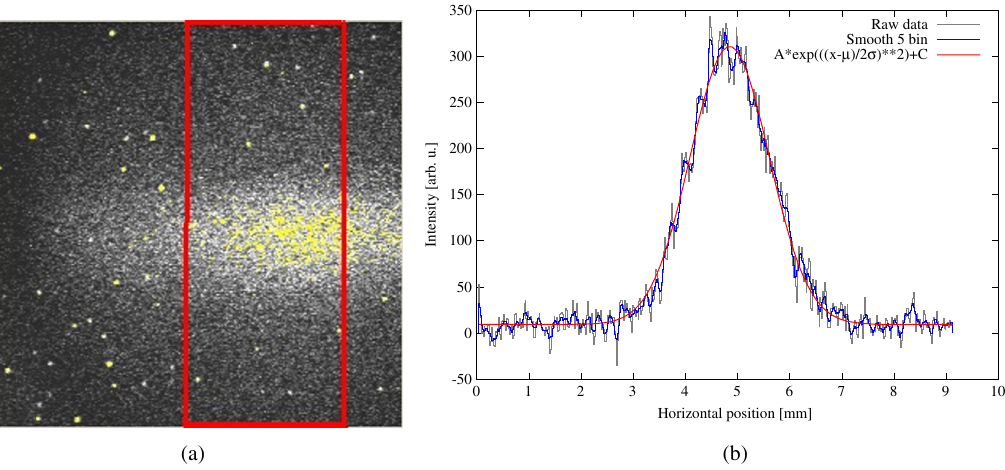
FIG. 9. Typical results of horizontal beam-size measurements with the CCD camera. (a) Fluorescence image of a 24 Mg þ beam after injection. In this picture, the abscissa represents the direction of beam propagation. (b) The horizontal beam profile evaluated by integrating the fluorescence data (a) within the red rectangular region.